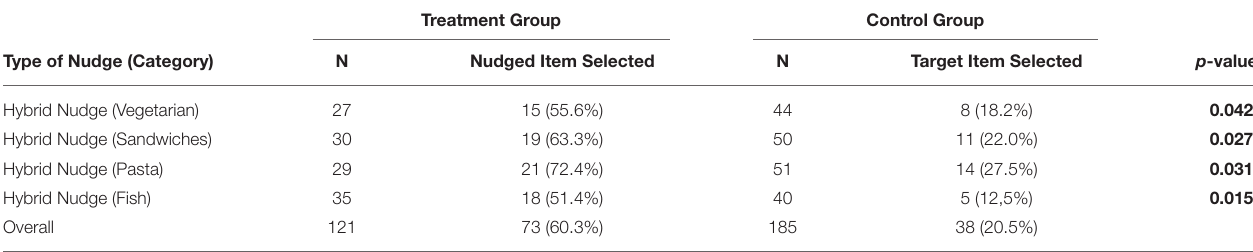
TABLE 3 | Effectiveness of all nudges in Study-2 except for the warning nudge.